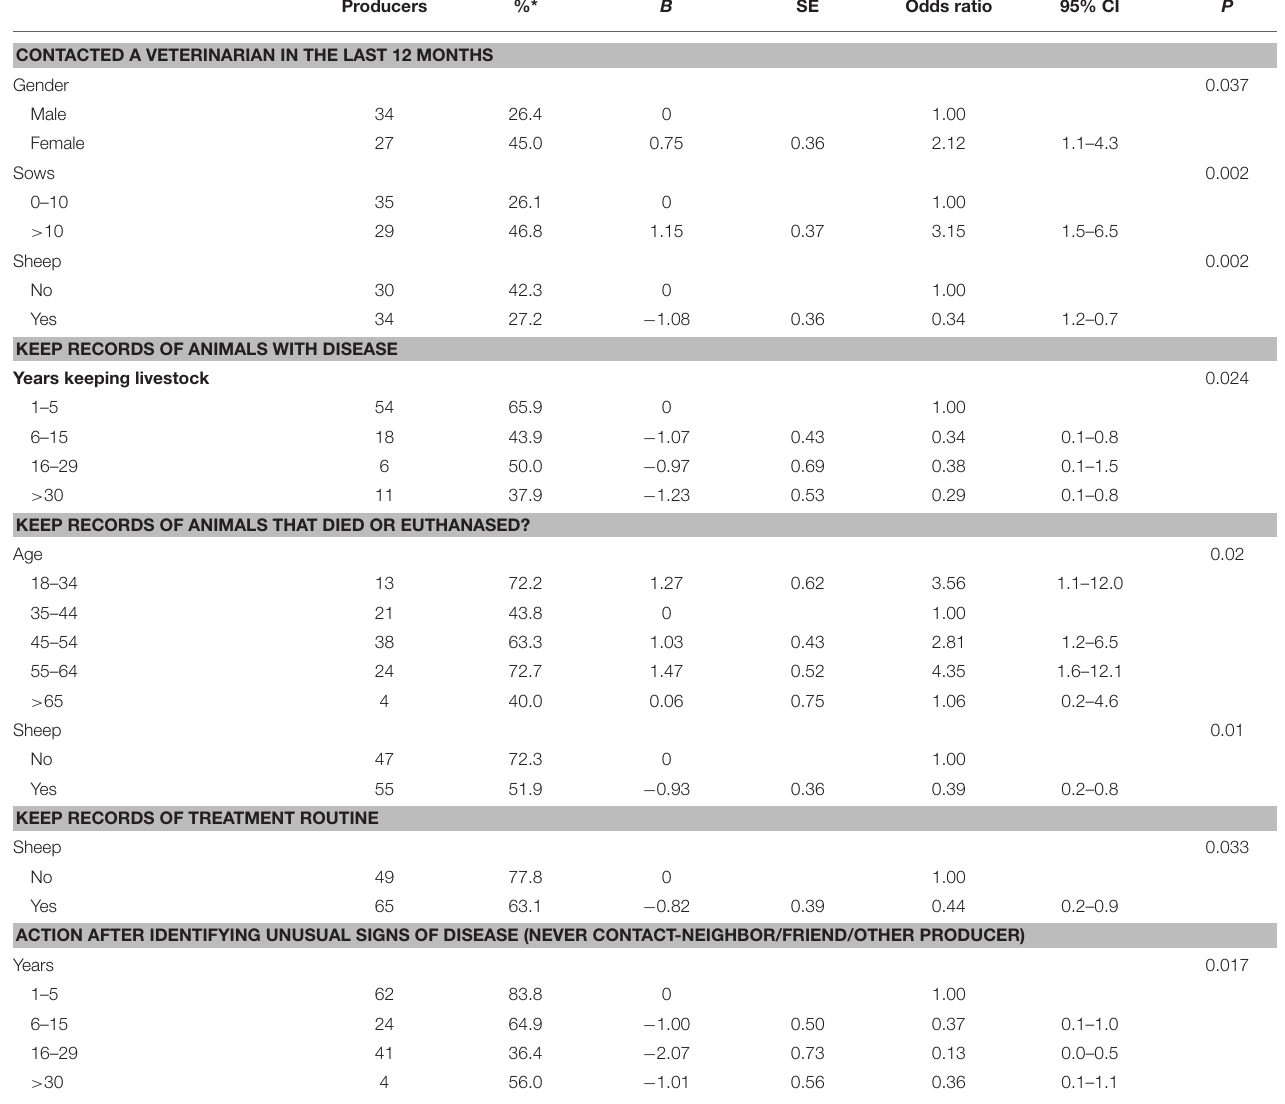
TABLE 5 | Results of a multivariable logistic regression analysis investigating animal health management related practices of 198 smallholders keeping pigs participating in a cross-sectional study in Australia in 2013–2015 (Only significant associations are shown). Producers %* B SE Odds